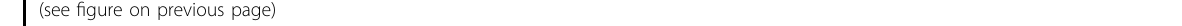
Fig. 4 SNHG1 could directly bind to hnRNPL and regulate EMT. A Hierarchical clustering of 1045 transcripts altered ( ≥ 1.5-fold change) in NC- treated cells and shRNA SNHG1 -treated cells with three repeats. B, C KEGG analysis and differential genes GSEA enrichment analysis demonstrated that cell adhesion molecules are the potential targets of SNHG1 pathway. D Volcanic map analysis of differential genes. E The altered mRNA levels of genes were selectively con fi rmed by qRT-PCR in knockdown SNHG1 . F SDS-PAGE silver staining of RNA pull-down protein samples showed a signi fi cant difference in protein band from 55 to 70 kDa. G Differential protein band mass spectrometry showed that the protein was hnRNPL . H The interaction possibilities of hnRNPL and SNHG1 were detected in RPIseq, and the results showed that hnRNPL could well bind with SNHG1 well (RPISeq). I Pull-down assays showed that biotinylated SNHG1 could retrieve hnRNPL in DU145 cells by western blot( fl ow-through was a input control). J RNA immunoprecipitation revealed that hnRNPL could also speci fi cally bind to SNHG1 . K , L The western blotting results after SNHG1 knockdown in DU145 and C4-2 cells showed that the expression level of hnRNPL did not change, while E-cad and Claudin-1 were signi fi cantly up-regulated, Vimentin, Slug and ZEB1 were signi fi cantly decreased. overexpression of SNHG1 showed an opposite effect of these protein in in DU145 and